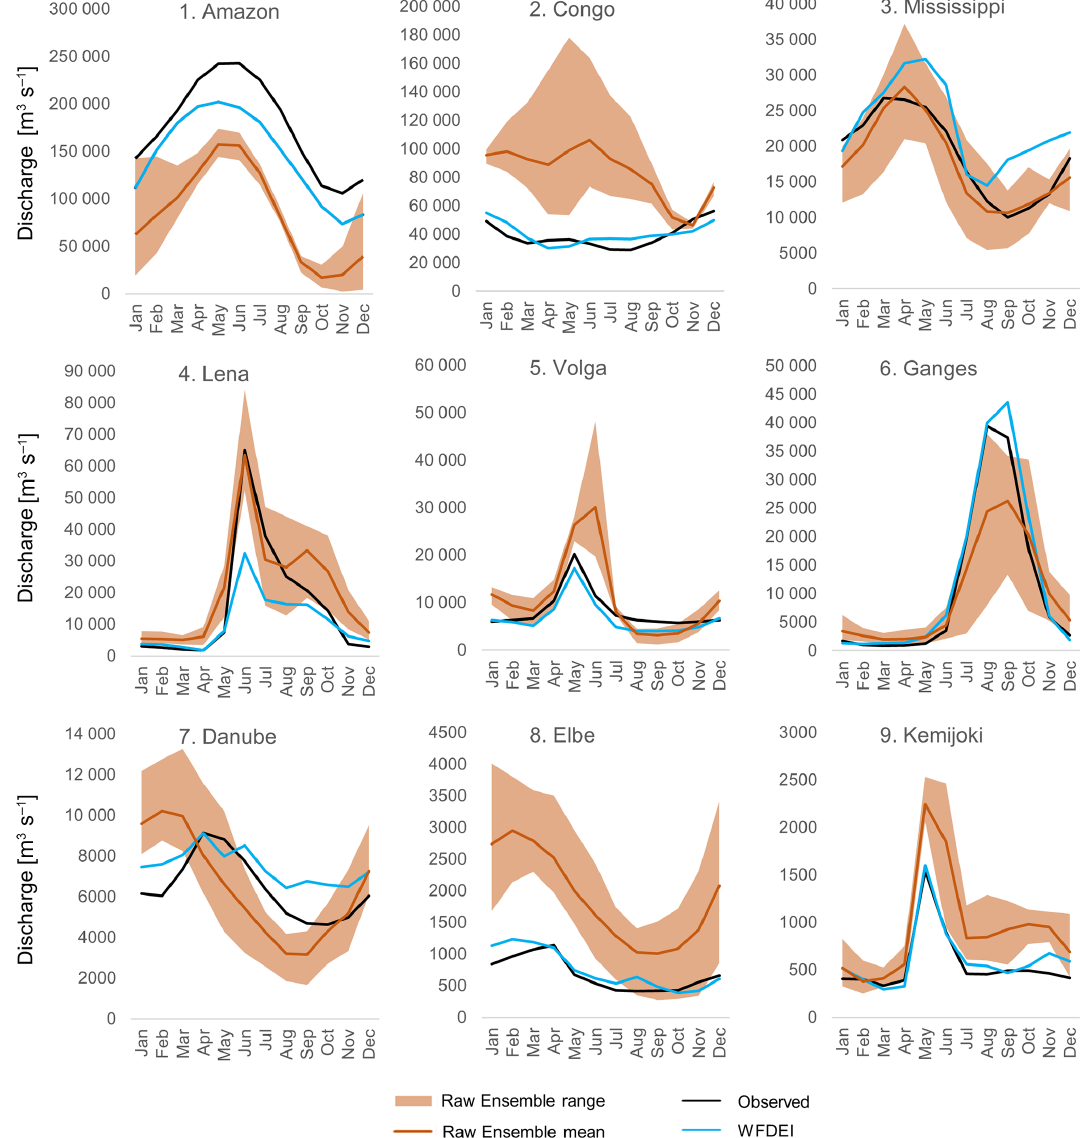
Figure 6. Discharge seasonality (m 3 s − 1 ) derived from the period 1981–2010 for nine study basins. Each panel shows observed discharge (GRDC measurements) compared to JULES’ simulated discharge from WFDEI data and raw GCM data (the mean and the range of the ensemble are